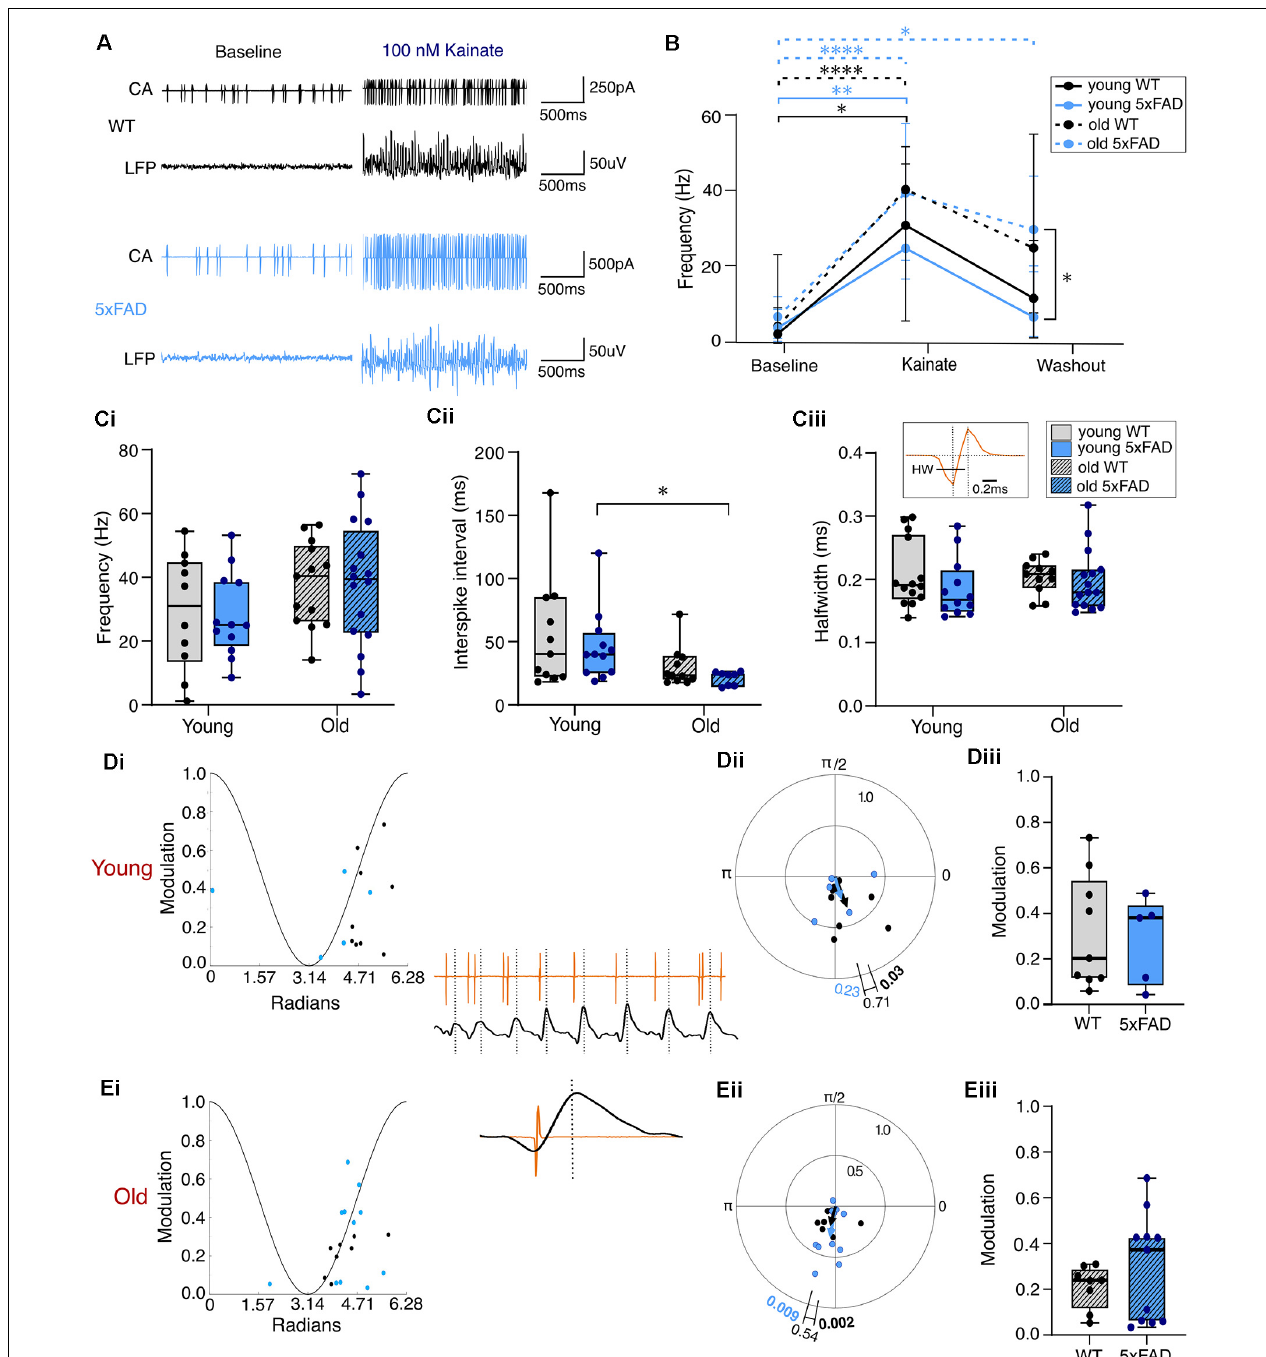
FIGURE 6 | PVIN firing properties during kainate-induced gamma oscillations. (A) Representative traces of simultaneously recorded PVIN firing (cell-attached, CA, recordings) and extracellular CA3 local field potential (LFP) in baseline and then during kainate application. (B) Progressive change in PVIN firing frequency during the wash in and wash out of kainate plotted as the median with error bars indicating the 95% confidence interval, solid line for young, and dashed line for old data. (Ci,Cii,Ciii) Spike frequency, inter-spike interval, and spike halfwidth of PVINs during kainate, respectively. The inset in (Ciii) shows a representative PVIN action potential with the halfwidth shown with scale bar for reference. (D,E) Phase-locking of the PVIN spikes in relation to the gamma oscillation with the peak of the cycle at 0 and trough at π in young (D) and old slices (E) . The angles of individual data points in (Di) and (Ei) represent the mean phase angle for a single PV cell. The vector length/modulation is a value between 0 and 1 indicating the degree of phase-locking with a value of 1 meaning the cell always fires at the same phase and a value of 0 meaning the cell fires randomly with no phase-locking. The lines on the polar plots (Dii,Eii) indicate the weighted average degree of phase locking for